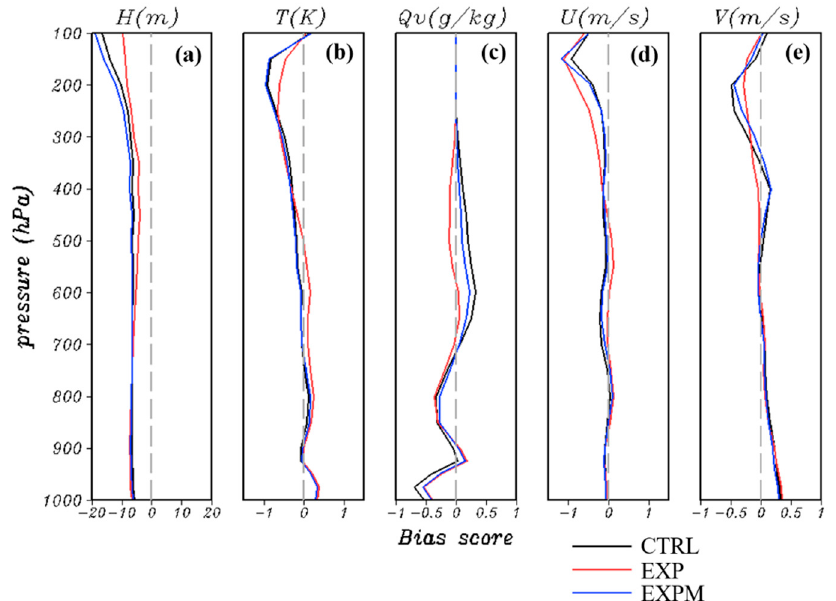
Figure 5. Vertical profiles of the biases of ( a ) geopotential height (m), ( b ) temperature (K), ( c ) specific humidity (g/kg), ( d ) zonal and ( e ) meridional wind (m/s) averaged over Asia ( 5 ° S ~ 55 ° N, 60 ° E~ 180 ° E) for 96~120 h forecast based on 32 daily cases from 0000 UTC 15 May 2020 to 0000 UTC 15 June 2020 against ERA5 reanalysis data from CTRL (black line), EXP (red line), and EXPM (blue line) experiments.